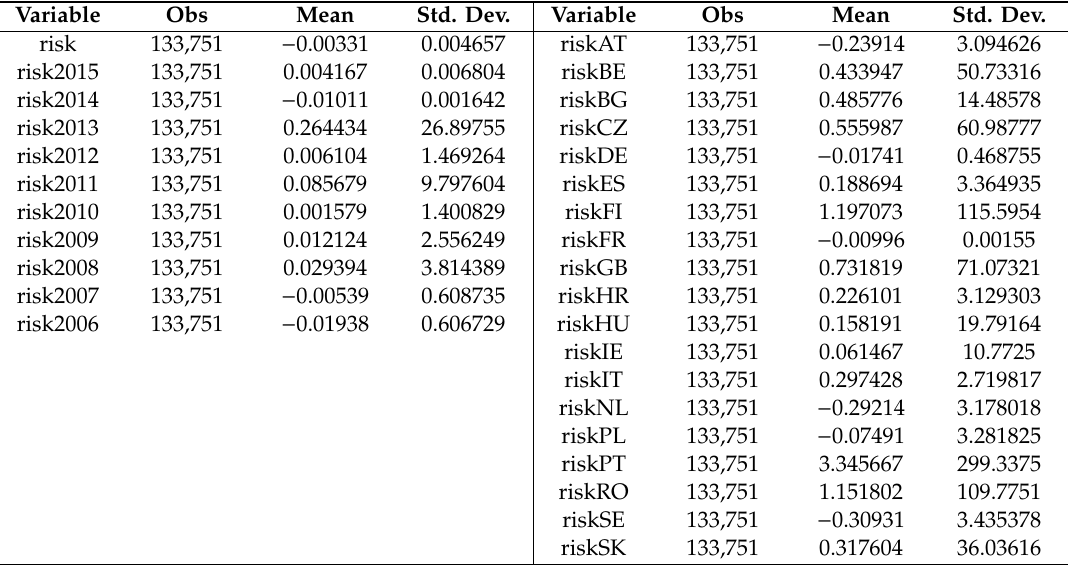
Table 3. Descriptive Statistics of scores computed based over Principal Component Analysis (PCA). Variable Obs Mean Std. Dev. Variable